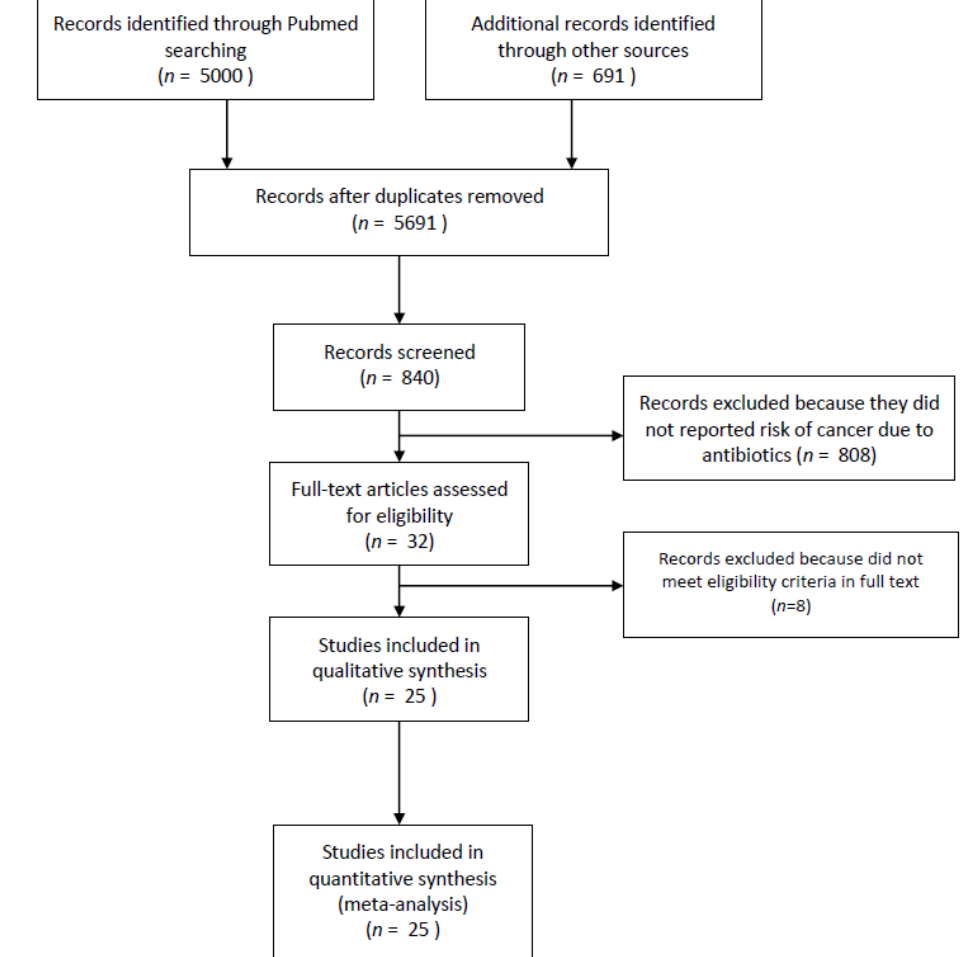
Figure 1. Flow diagram summarizing the literature search.